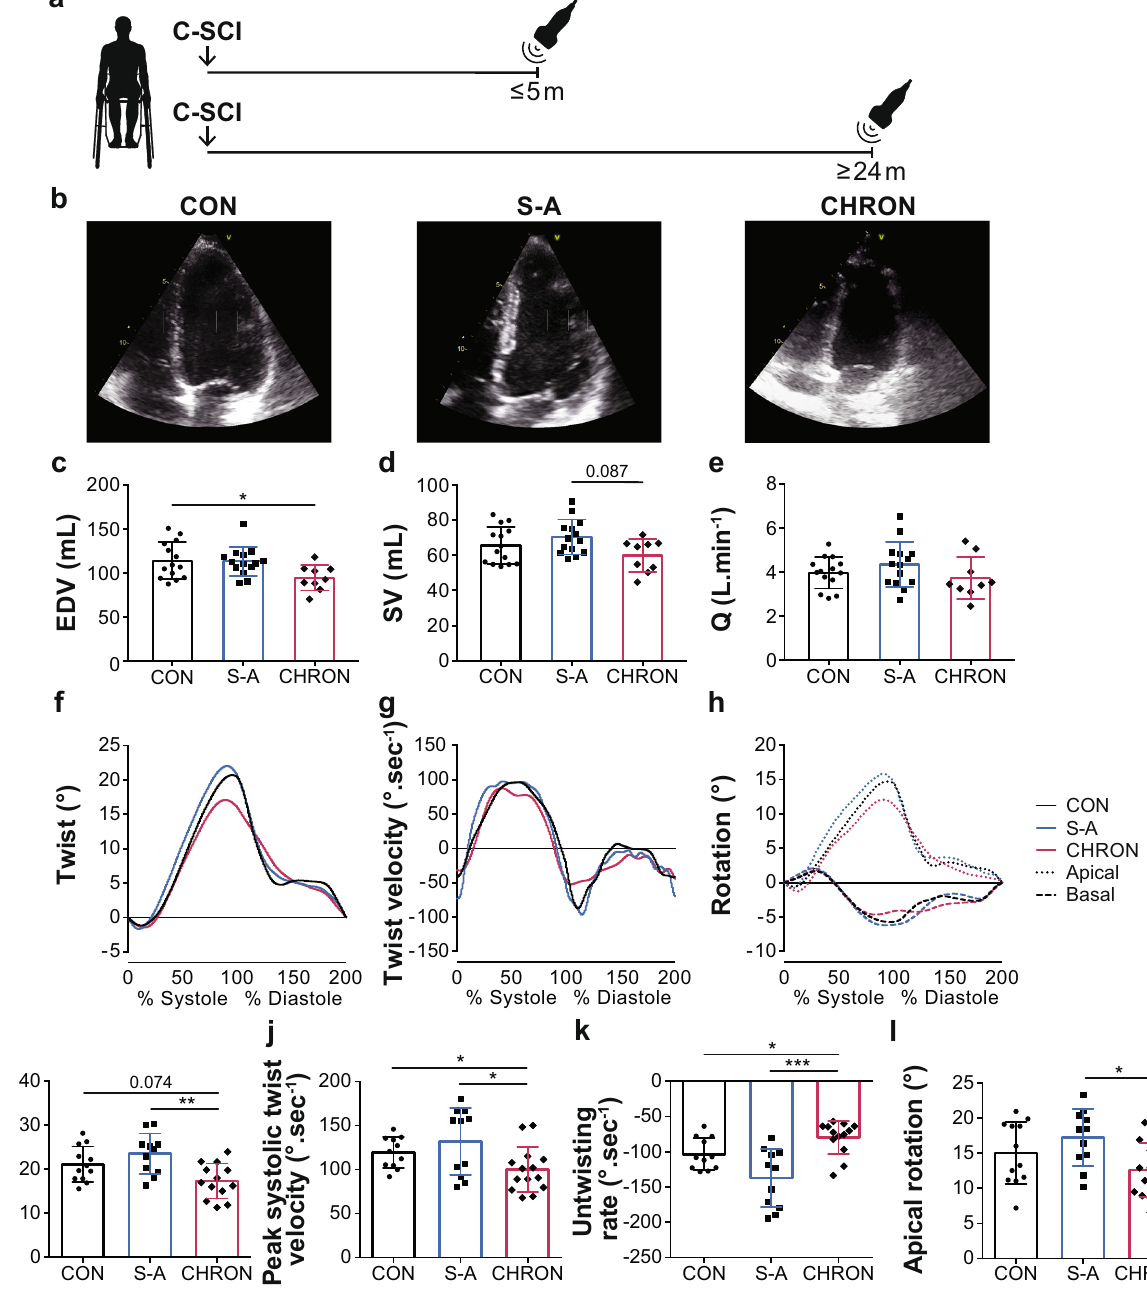
Fig. 2 Temporal progression of echocardiography-derived LV functional, volumetric, and mechanical outcomes in human participants with cervical SCI. a Echocardiography was performed cross-sectionally on non-injured control individuals (CON), and on cervical SCI individuals at ≤ 5 months in the sub- acute period (S-A) and at ≥ 24 months in the chronic period post SCI (CHRON). b Representative apical four-chamber images of previously described groups (scaled to each other). c End-diastolic volume (EDV) was reduced in CHRON vs. CON with similar trends for d stroke volume (SV) and e cardiac output (Q). Panels c – e represent data from n = 14 CON, n = 14 S-A, n = 9 CHRON). f Ensemble-averaged twist, g twist velocity, and h rotation curves during one cardiac cycle across all participants in each group (panels represent data from n = 11/12 CON, 11 S-A, and n = 13 – 16 CHRON). i Twist was lower in CHRON vs. S-A and tended to be lower in CHRON vs. CON. j Peak systolic twist velocity was slower in CHRON vs. both CON and S-A. k Untwisting rate was slower in CHRON vs. both CON and S-A. l Apical rotation was lower in CHRON vs. S-A, while basal rotation was not. Bar graph data are presented as mean ± SD with individuals represented as symbols ( n = 9 – 16/group) and were analyzed using a one-way ANOVA and Tukey HSD post hoc test: * p < 0.05, ** p < 0.01, and *** p < 0.001. See Supplementary data 1 for detailed statistics and other echocardiography-derived outcomes. See Supplementary Table 1 for participant characteristics. Source data are provided for all variables shown in this fi gure in the source data fi